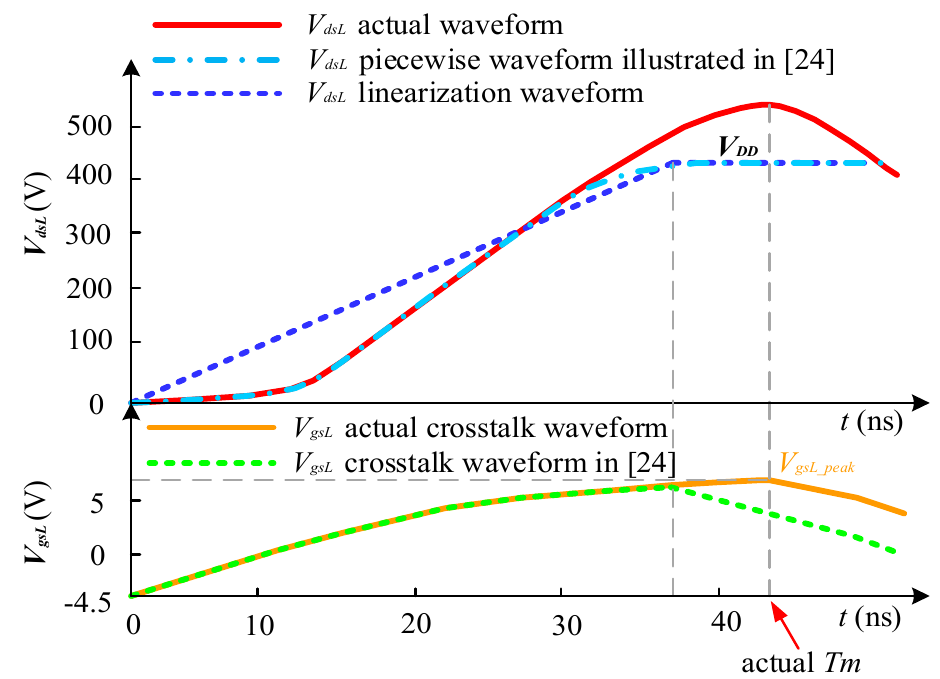
Figure 7. The formation of crosstalk in voltage switching stage of turn-on process.